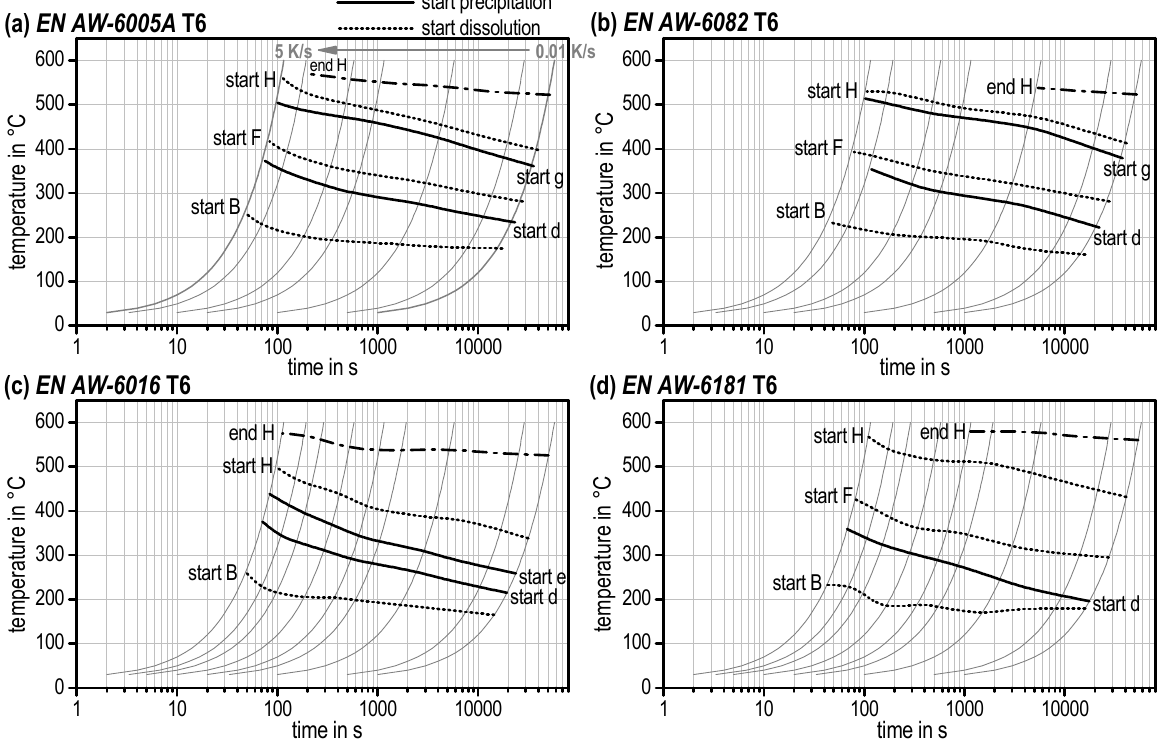
Figure 10. Continuous heating dissolution diagrams for the T4 initial condition of several aluminium alloys ( a ) EN AW-6005A. ( b ) EN AW-6082. ( c ) EN AW-6016. ( d ) EN AW-6181.